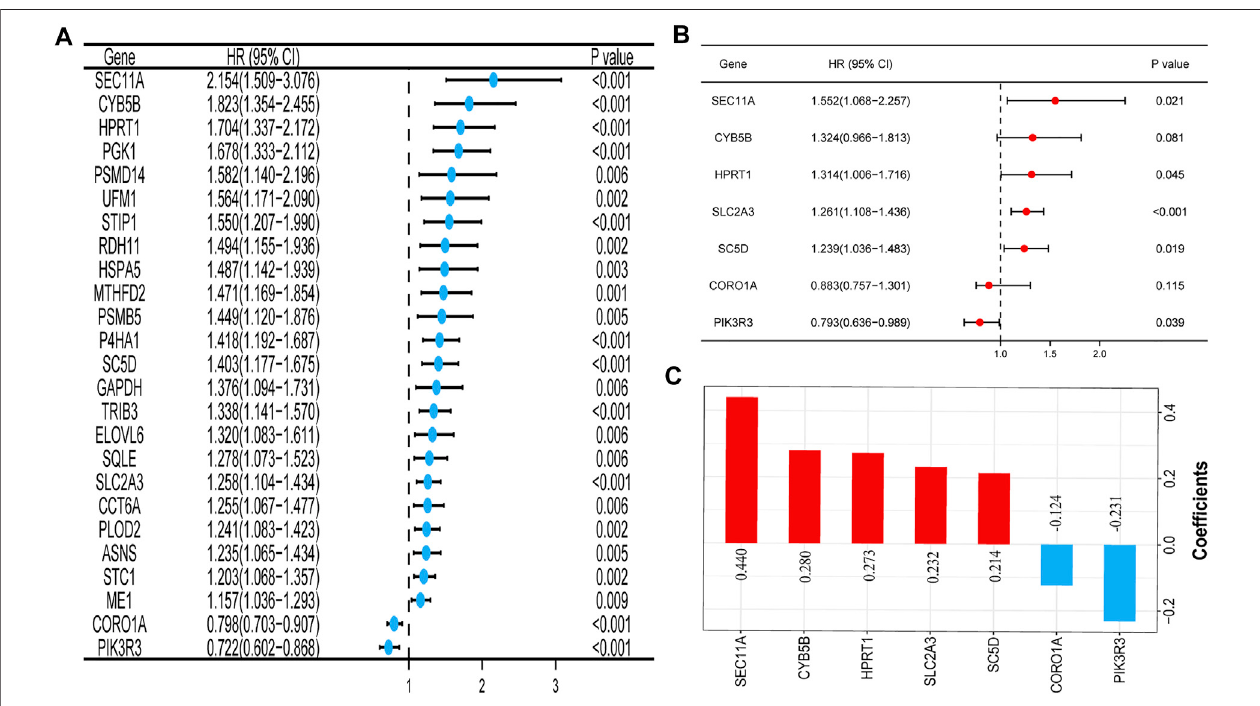
FIGURE2| ConstructionoftheprognosticsignatureofthemTORsignalingpathway – relatedgenesinTCGAcohort. (A) ForestplotoftheunivariateCoxregression analysis of 25 prognosis-related genes. (B) Seven genes identi fi ed by the multivariate Cox regression analysis were used to construct a prognostic signature. (C) Coef fi cients of the seven genes included in the signature. Abbreviations: mTOR, mammalian target of rapamycin; TCGA, The Cancer Genome Atlas.